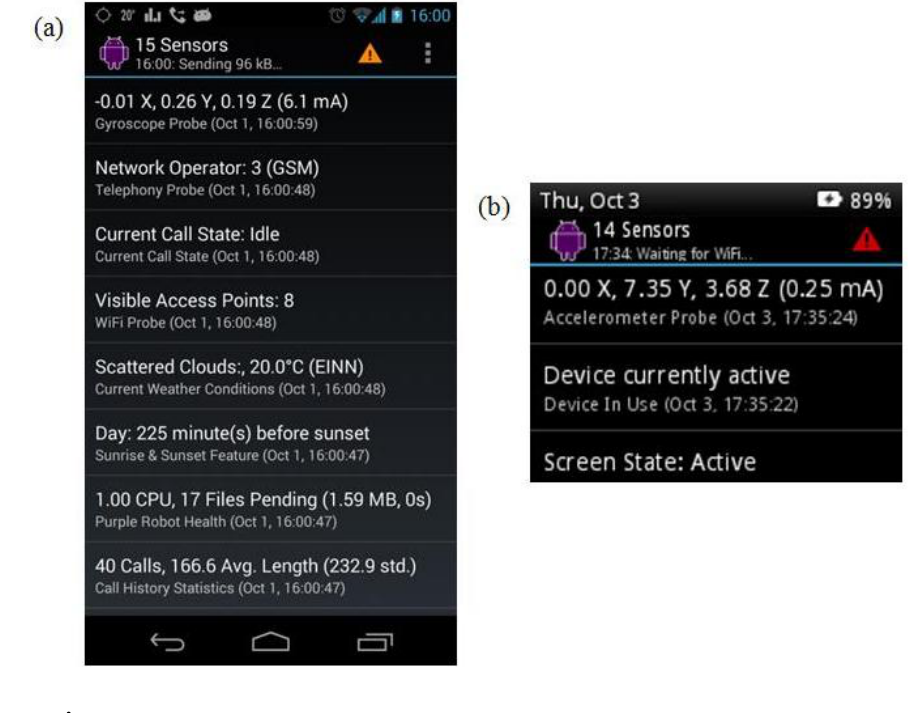
Figure 1. ( a ) Android application running on smartphone; and ( b )